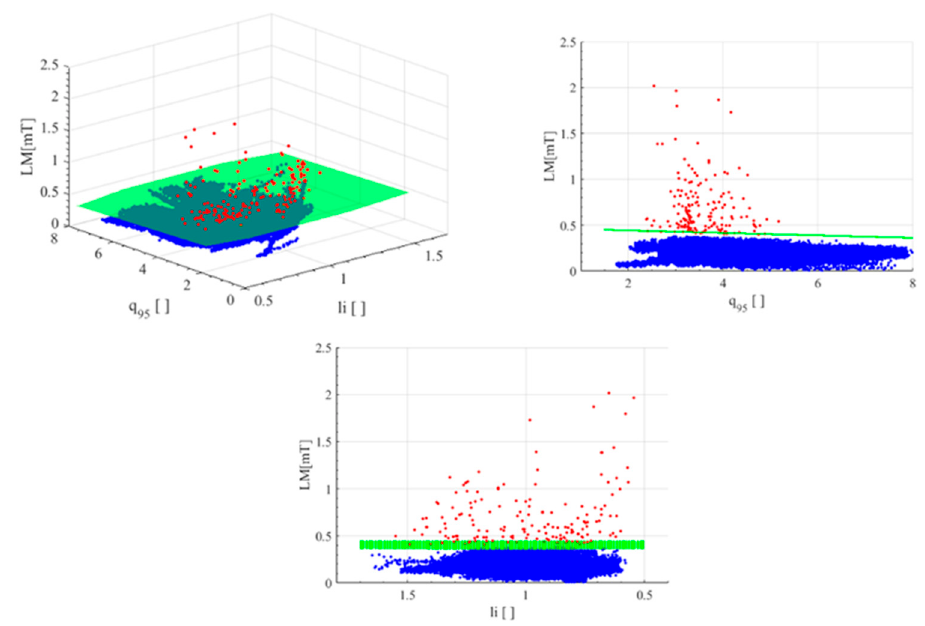
Figure 8. The boundary between the safe and disruptive regions of the operational space for campaigns C29 and C30. Top left: in the three dimensions LM, li and q 95 . Top right and bottom: the two projections. Blue safe points, red disruptive points. The hypersurface obtained with symbolic regression and non-linearly fitted to the data is shown in green. Only the first disruptive point of each discharge has been reported to help with visualizing the behaviour of the data. Table 5. Performance of Equation (4) for campaign C31. The models obtained at the end of C30 have been applied to the examples of C31 without any retraining.